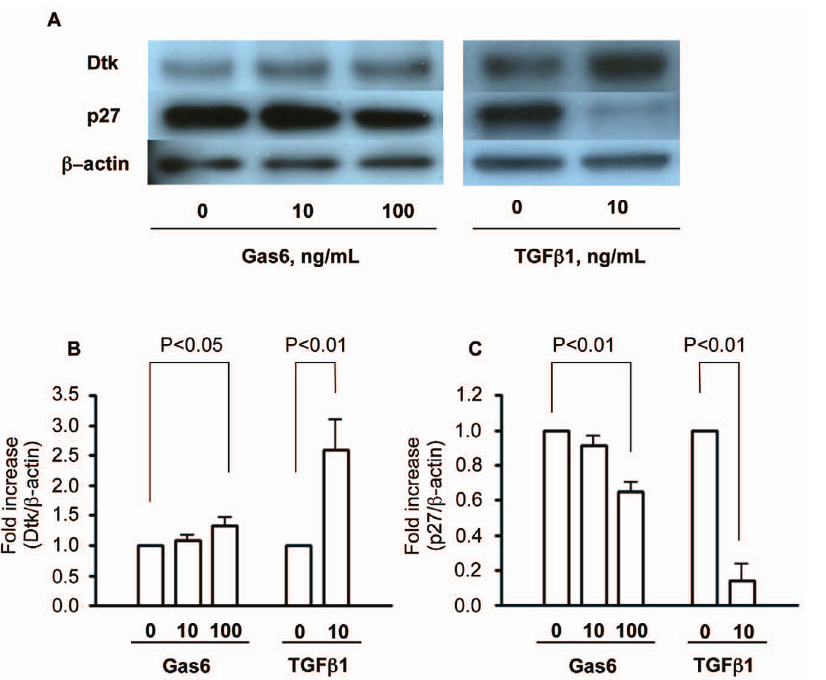
Figure 7. Effect of Gas6 on Dtk and p27 expression in podocytes. Podocytes were differentiated and stimulated with recombinant Gas6 or TGF b 1 for 24 hours. Cell lysates were subjected to immunoblotting with the antibodies indicated. Then, podocytes expressed Dtk. Gas6 could increase the expression of Dtk and reduce p27, as well as TGF b 1. Representative data were shown from four independent experiments. Quantitative examinations of the band density for (B) Dtk and (C) p27 were shown. The columns and error bars are the mean 6 SD of four independent experiments.